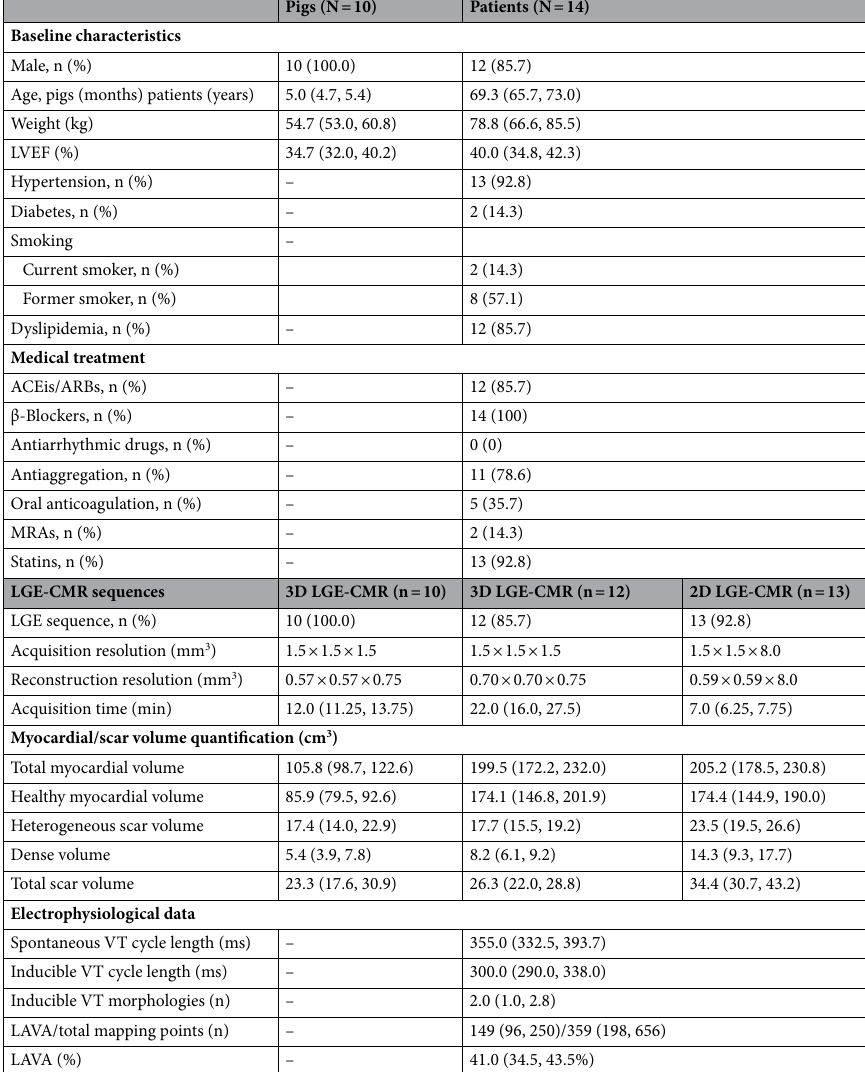
Table 1. Baseline patient and animal characteristics. Values are expressed as median and interquartile ranges or n (%), as appropriate. ACEis: angiotensin converting enzyme inhibitors, ARBs: angiotensin II receptor blockers, LAVA: local abnormal ventricular activities, LGE-CMR: delayed gadolinium-enhancement cardiac magnetic resonance, LVEF: left ventricular ejection fraction, MRAs: mineralocorticoid receptor antagonists, VT: ventricular